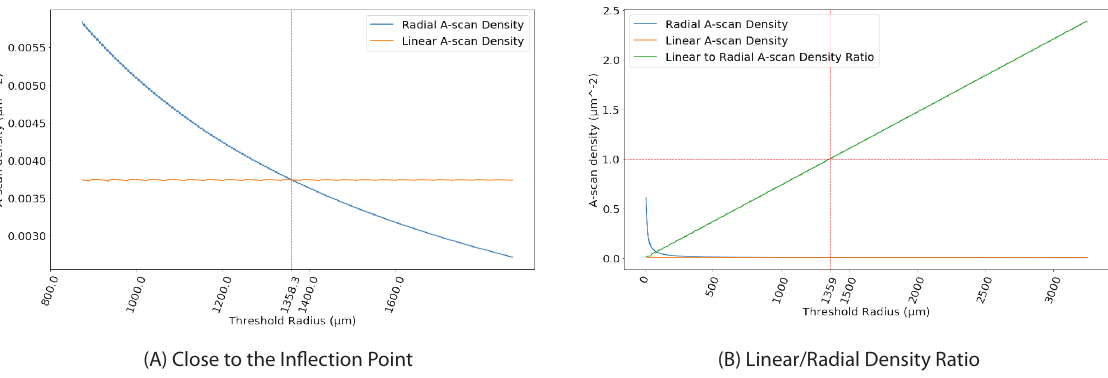
Figure 6. In plot ( A ) the intersection represents the existence of the Inflection Point. ( B ) shows the density ratio of linear to radial